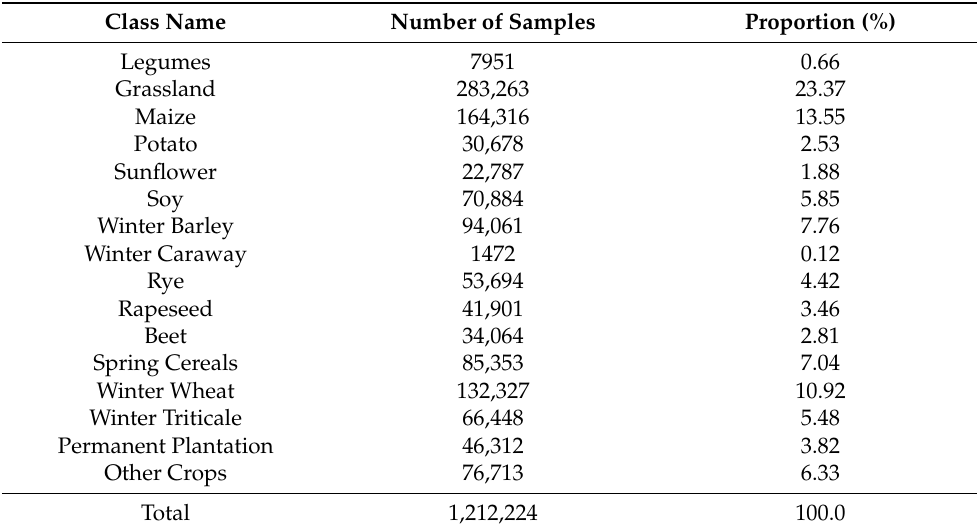
Figure 3. Study area of TimeSen2Crop: Austria. Table 2. Sample Statistics of